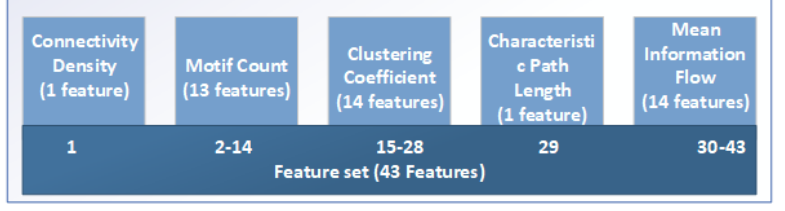
Figure 7. The complete feature